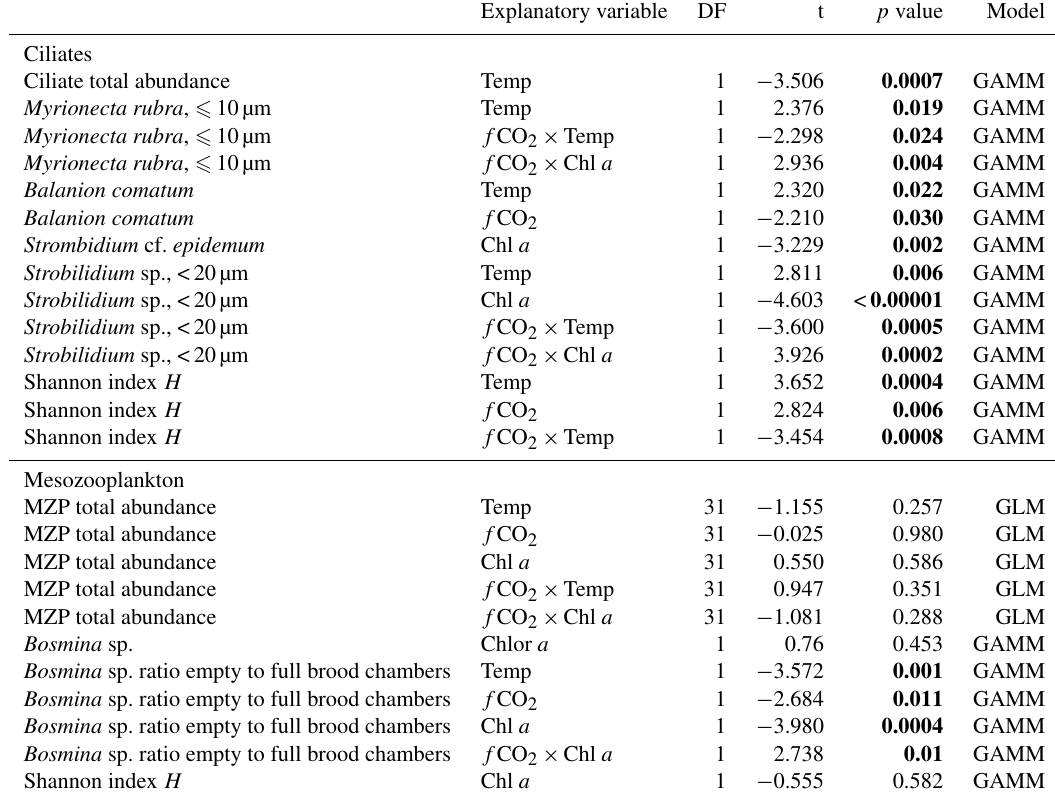
Table 1. Statistics summary table of retained fixed effects of the GLM models and GAMMs. Significant p values are indicated in bold (Temp: